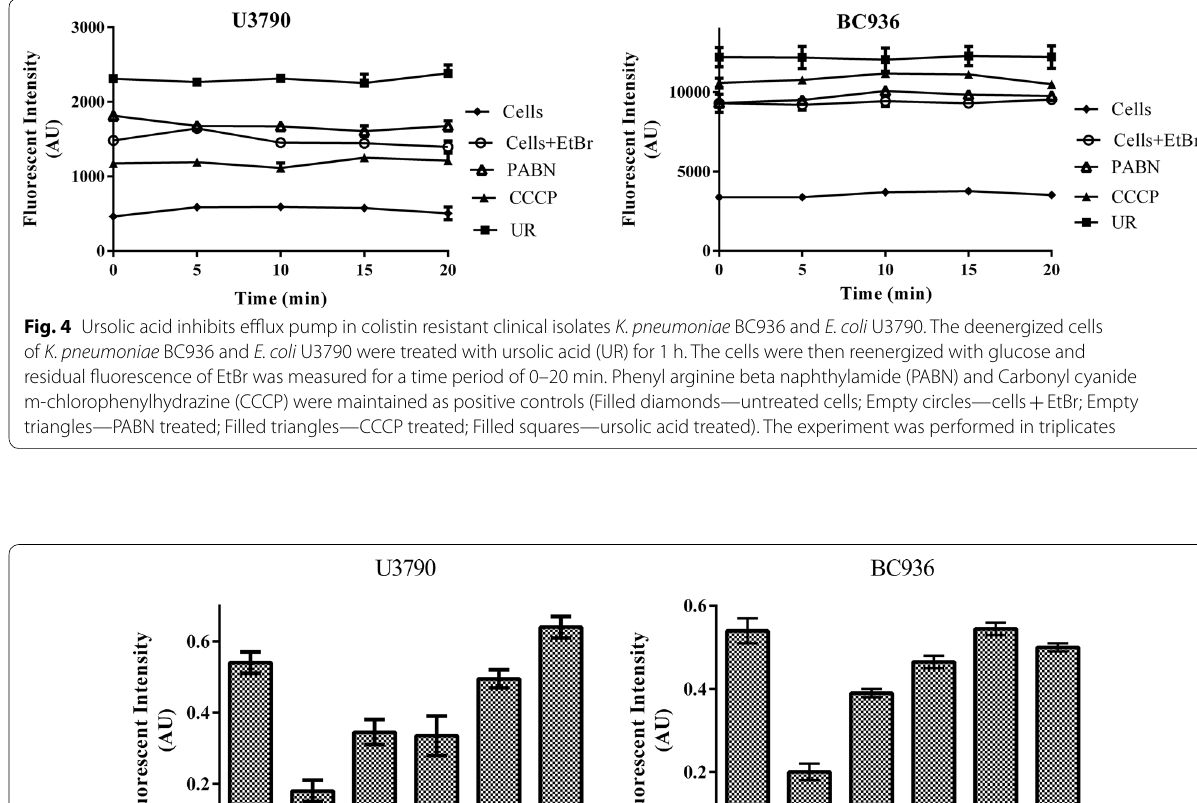
ursolic acid (Col UR) in the presence of DiSc3. The fluorescent intensity was + +